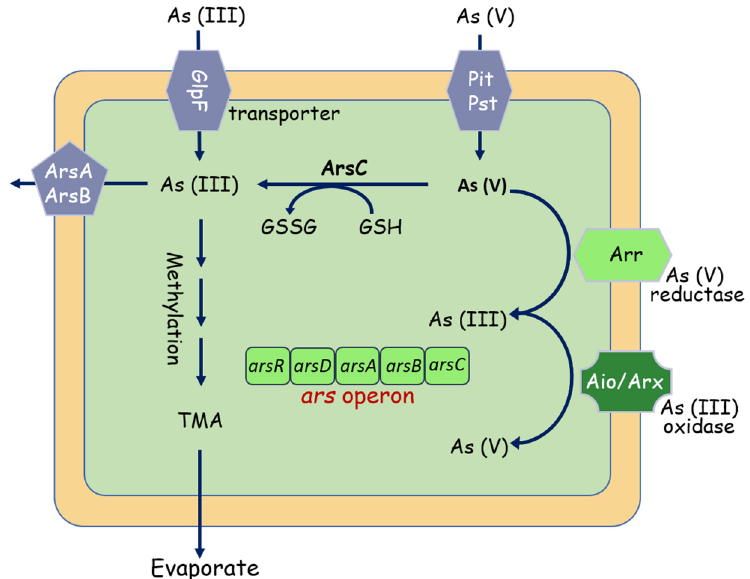
Figure 4. Overview of bacterial interactions with arsenic. Under aerobic conditions, As(V) enters the cell via phosphate uptake systems (PstA, PstB). As(V) is then reduced by the arsenate reductase ArsC to As(III). As(III) can also directly be taken up aquaglyceroporins such as GlpF, and then bound by the As(III)-binding chaperone ArsD and extruded by ArsAB efflux pump. As(III) can also be methylated, forming the trimethyl arsine (TMA), pumped out by the ArsP transporter.